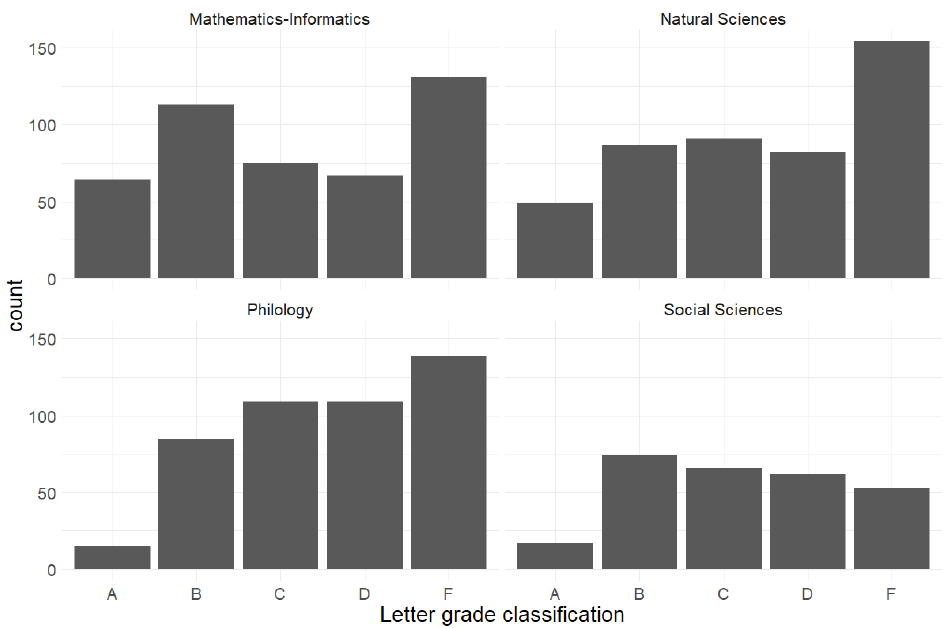
Figure 1. Counts of high schools by last admission grade-letter grade classification.